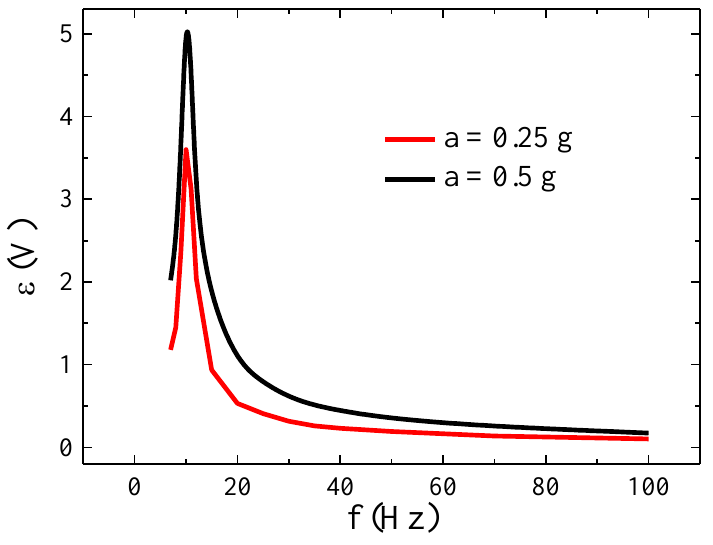
Figure 6. Induced emf , ε , in the harvester as a function of vibrating frequency for the accelerations: a = 0.5 g and a = 0.25 g.